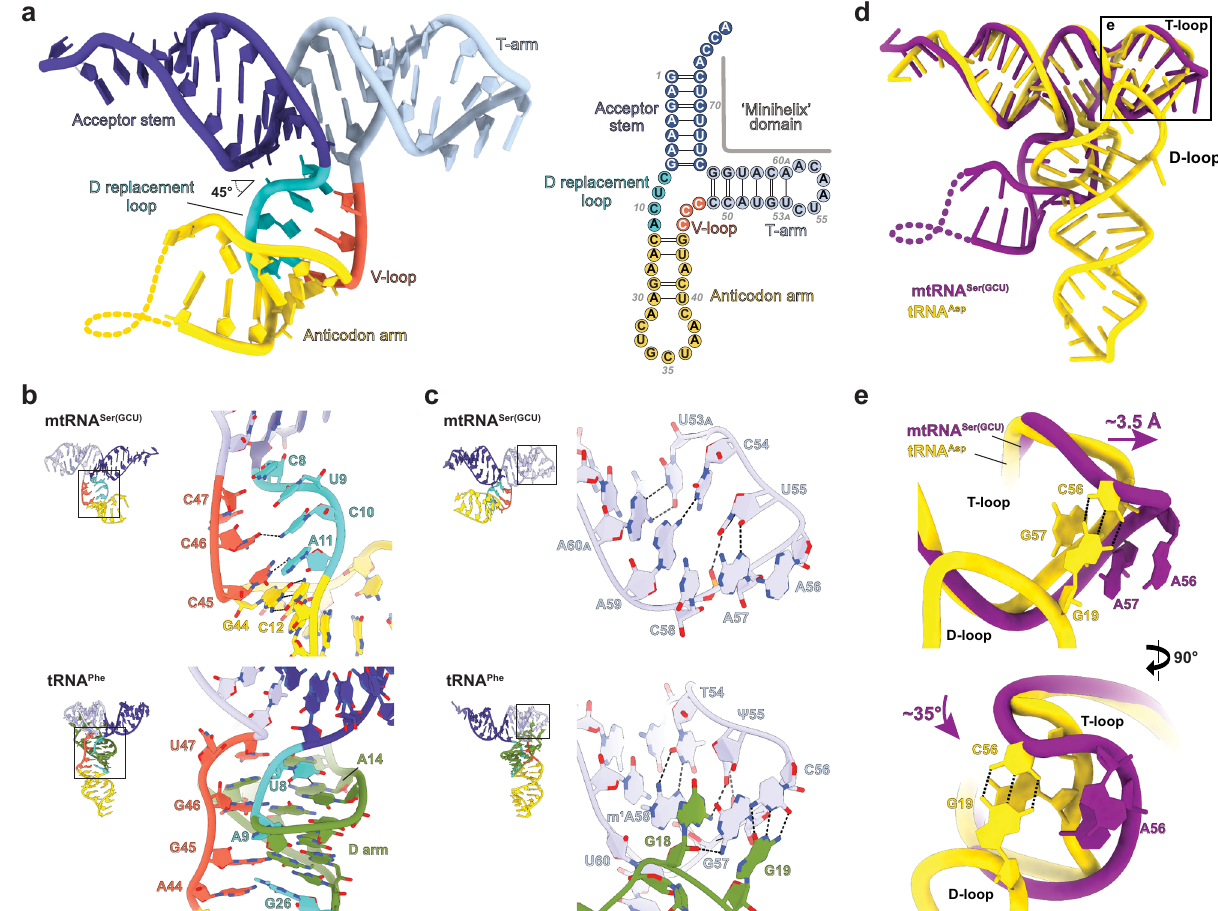
Fig. 2 | The non-canonical structure of mtRNA Ser(GCU) . a Tertiary (left) and sec- ondary (right) structure of mtRNA Ser(GCU) . The portion of the anticodon arm missing in the reconstruction is indicated as yellow dashed line. b Details of the tRNA ‘ core ’ region in mtRNA Ser(GCU) (top) and the canonical S. cerevisiae tRNA Phe (bottom; PDB 4TRA) with view on the variable loop (orange). Color code as in a . The D-arm of tRNA Phe , which is absent from mtRNA Ser(GCU) , is shown in green. c Details of the T-loop/elbow region in mtRNA Ser(GCU) (top) and the canonical S. cerevisiae tRNA Phe (bottom).Colorcodeasin a .TheD-loopoftRNA Phe isshownin